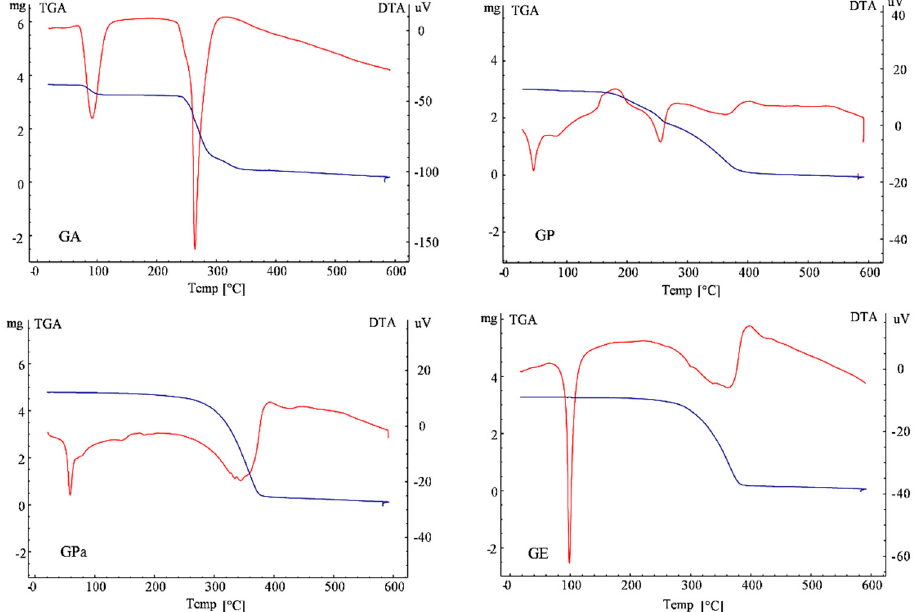
Figure 7. The TGA-DTA curve of gallic acid (GA), galloyl phytol (GP), galloyl phytanol (GPa) and galloyl eicosanol (GE). The blue line was the TGA curve, and the red line was the DTA curve. The second endothermic peak of gallic acid at 264.35 ◦ C (Tp) was its melting point along with decomposing as indicated by the weight loss in TG. The melting and decom- posing peaks of GPa (Tp 344.54 ◦ C) and GE (Tp 361.65 ◦ C) corresponding to the